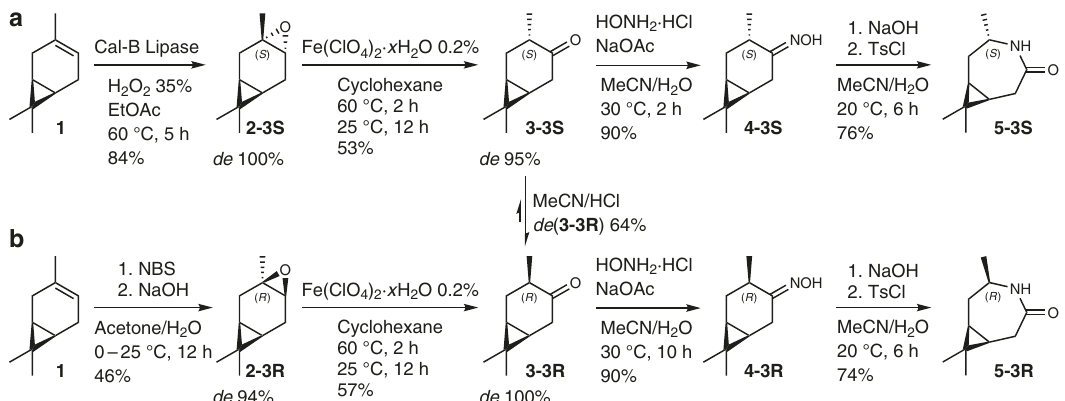
Fig. 1 Monomer synthesis overview. Synthesis pathway with yields and diastereomeric excess (de) of intermediates for the production of the lactam isomers 5-3S and 5-3R (yields refer to the small-scale experiments from puri fi ed starting material). The labelling of the stereo-centre C3 at all intermediates follows the recommendation for terpene carbon skeleton numbering of M. W. Graf fl in, which suggest that the initial carbon labels of ( + )-3- carene are fi xed also in case of functionalization